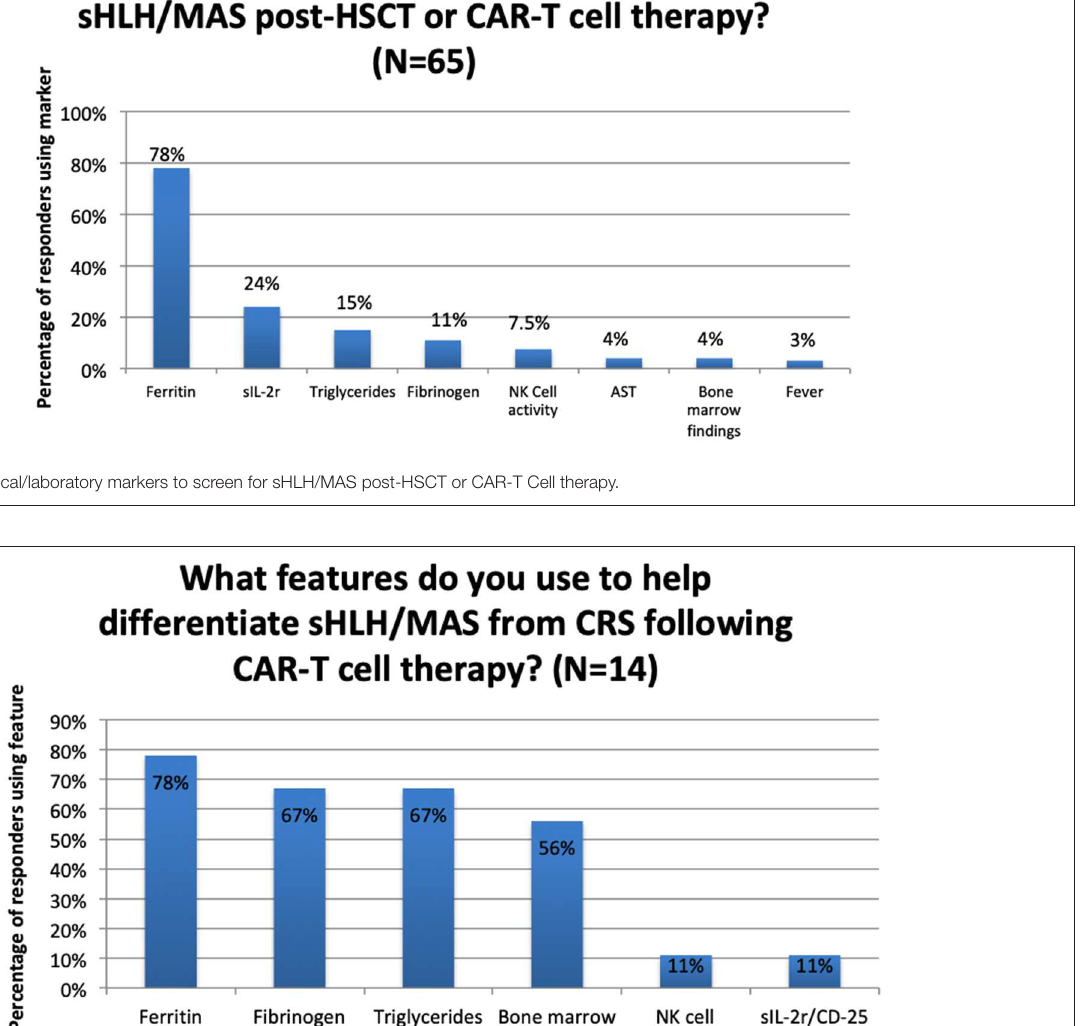
reported cut-off values are reported in Figure 3 . The responses to this question were free text and a further 10 different values (not shown in Figure 4 ) were reported, ranging from 10 to 8,000 µ